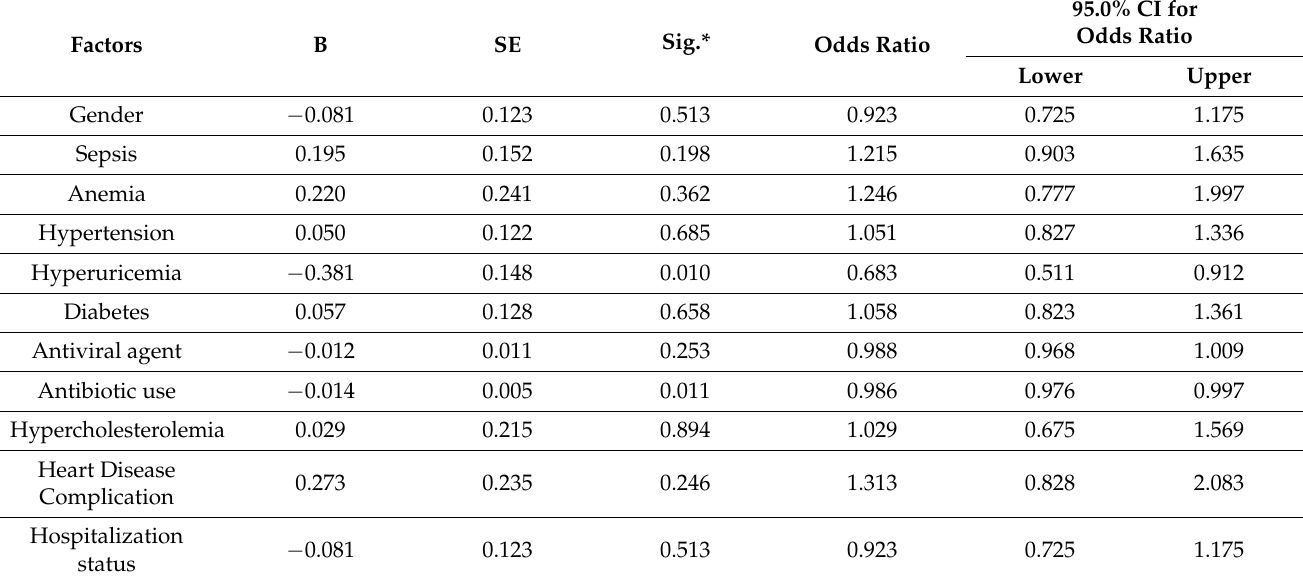
Table 4. Contributing factors to CKD following COVID-19